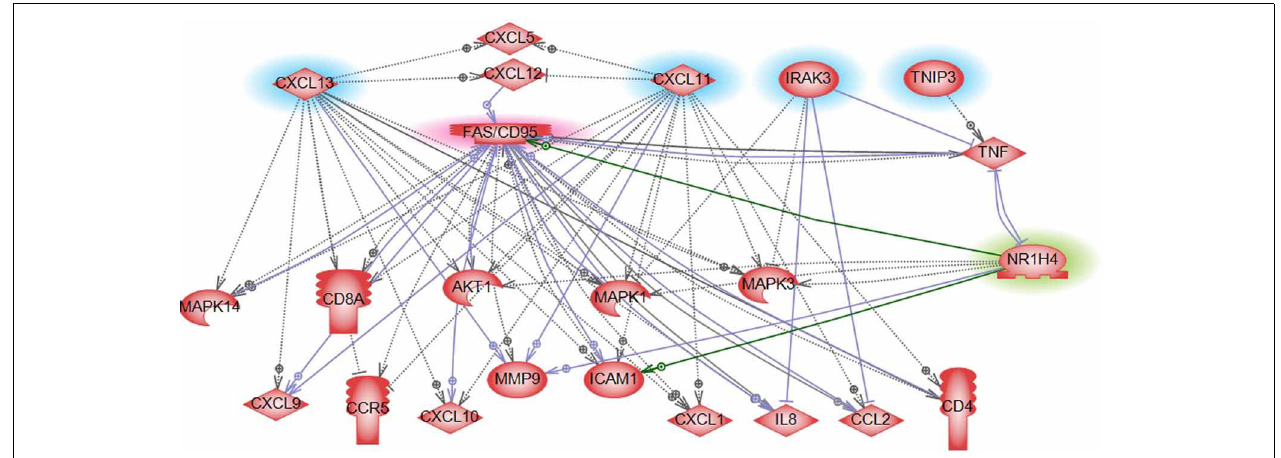
FIGURE 10 | Pathway analysis of FXR/NR1H4 gene. Pathway analysis showed FXR in a complex network with significant genes identified from other omics data in our analysis. Blue highlight: Gene expression top features